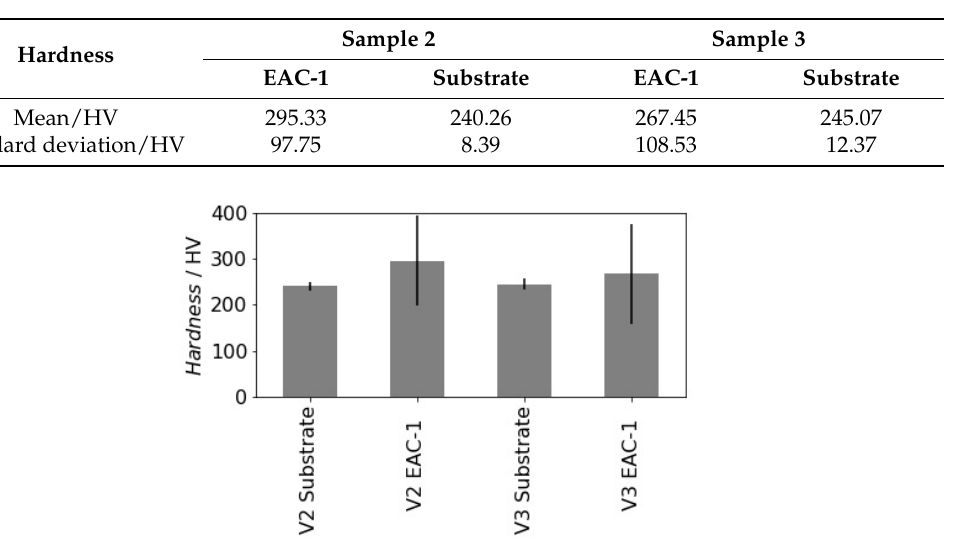
Figure 7. Average hardness values and corresponding standard deviations of substrates and deposited EAC-1 films.